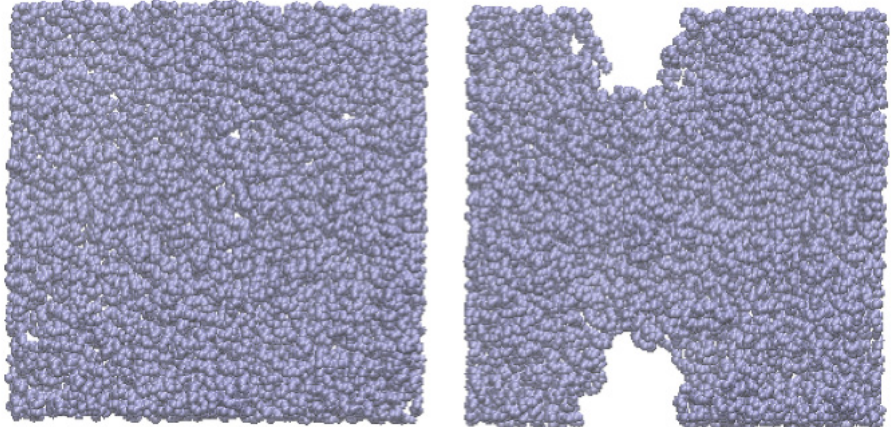
Figure 1. Normal views of the representation of a thin layer (interfaces grow infinitely on the paper plane) of linear polyethylene (C 200 ), made of Lennard–Jones sites in equilibrium at T = 473 K. The simulation cell used A i = 145 Å × 145 Å . Thin layers with 102 or more chains (left) were stable up to 0.1 μ s, while layers with 101 or fewer chains (right) contracted and developed stable nano-sized holes.